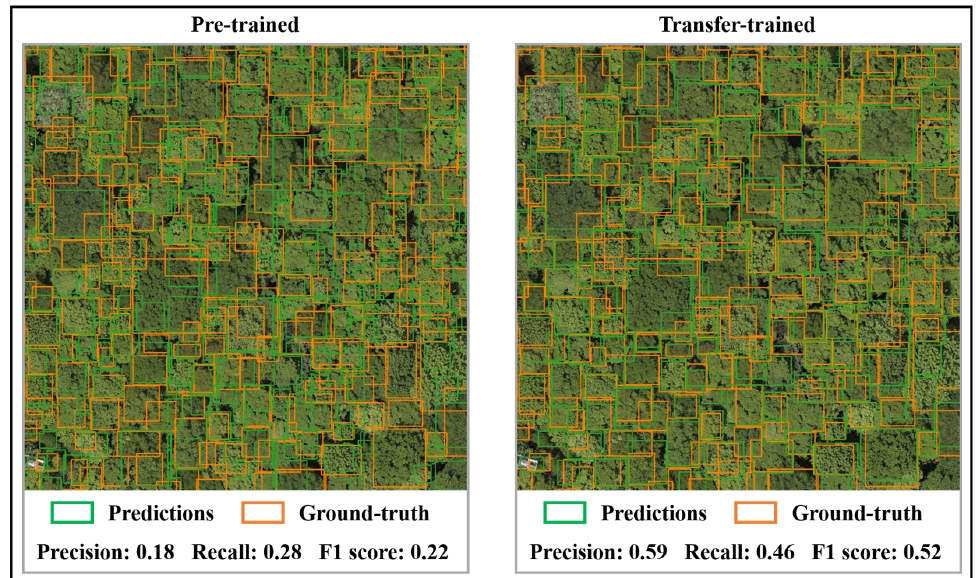
Figure 3. The tree crown detection of the pre- and transfer-trained DeepForest methods derived from UAV-based RGB imagery in the studied temperate, deciduous forest. The green and orange bounding boxes represent the predicted and ground truth tree crowns.